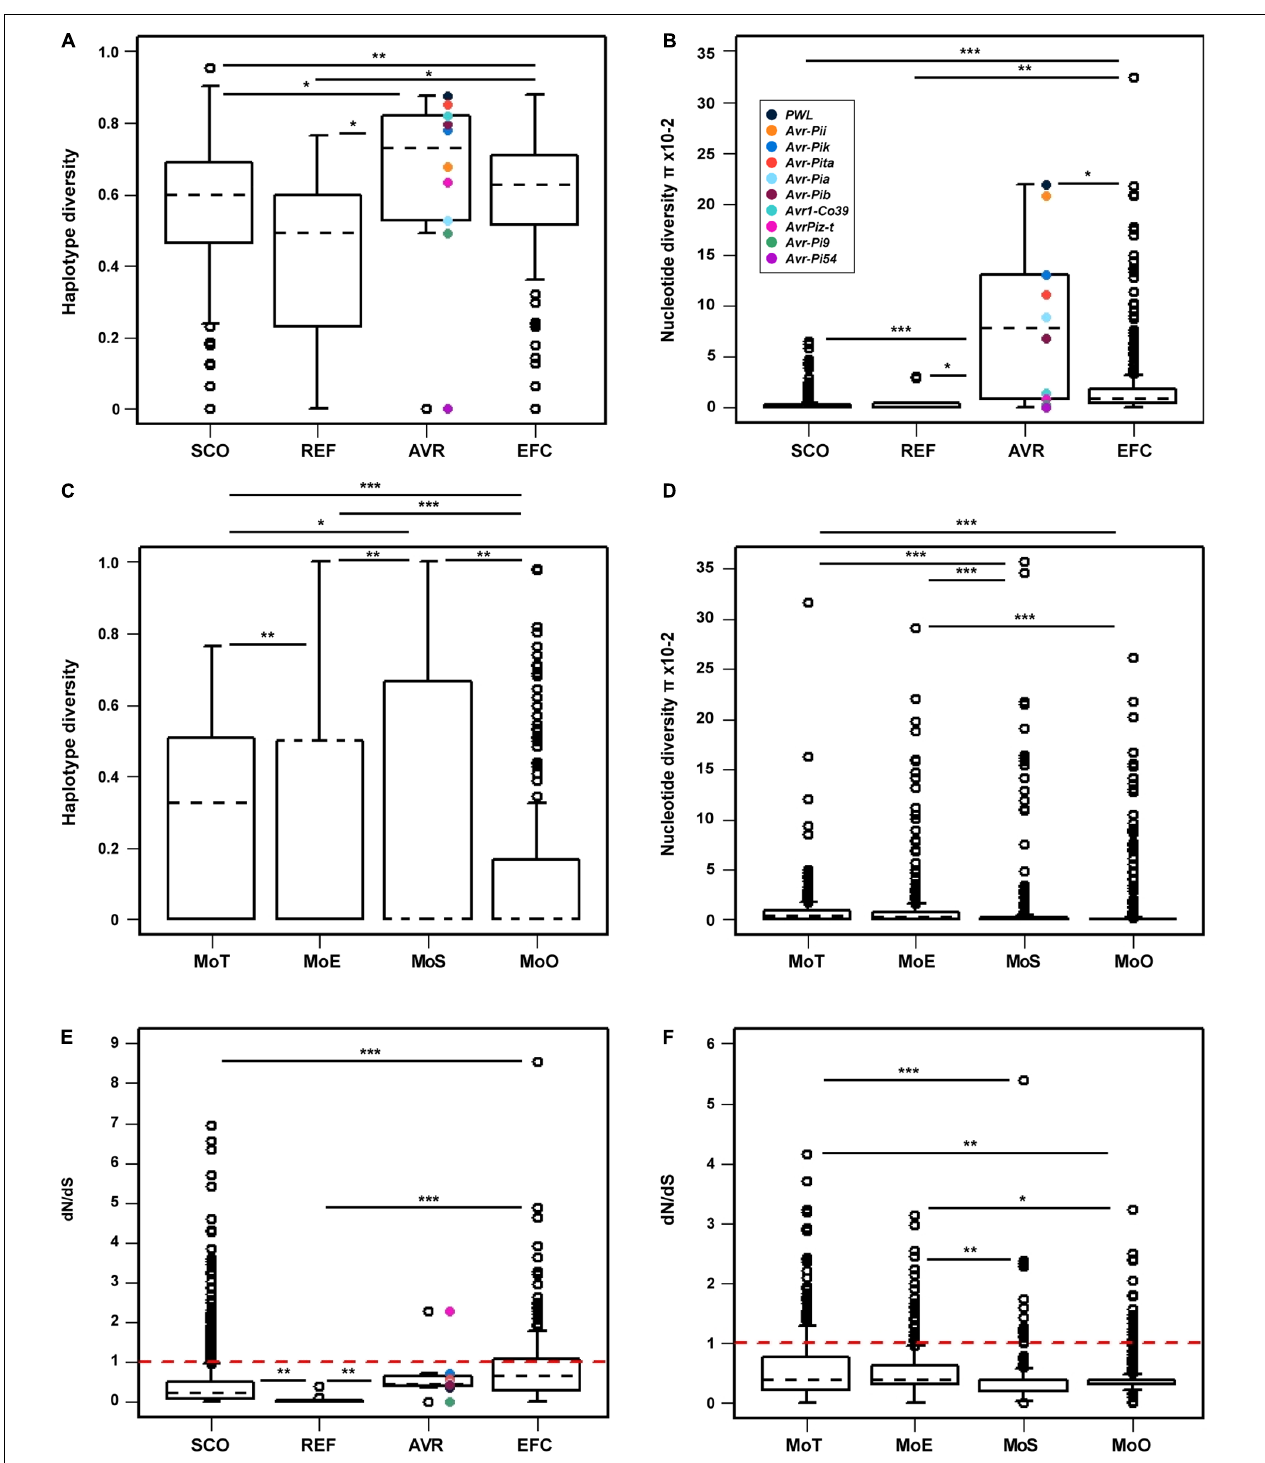
FIGURE 6 | Comparison of the haplotype diversity, nucleotide diversity, and mean selection pressure among four gene sets. The (A) haplotype and (B) nucleotide diversities within each gene set are presented for comparison. The AVR genes are color-coded in both figures. The (C) haplotype and (D) nucleotide diversities of the EFC genes in four pathotypes are shown. Because only one MoL isolate was used, it was not included in this analysis. (E) The mean selection pressure on each of the four gene sets and (F) that on the EFC genes in four pathotypes are shown. The red dashed line in both (E,F) indicates neutral selection pressure (dN/dS = 1). In all figures, black dashed lines denote the median values for each gene set or pathotype. The asterisks represent significant differences in distribution according to the Wilcoxon rank sum test ( ∗ P ≤ 0.05, ∗∗ P ≤ 0.01, and ∗∗∗ P ≤ 0.001).